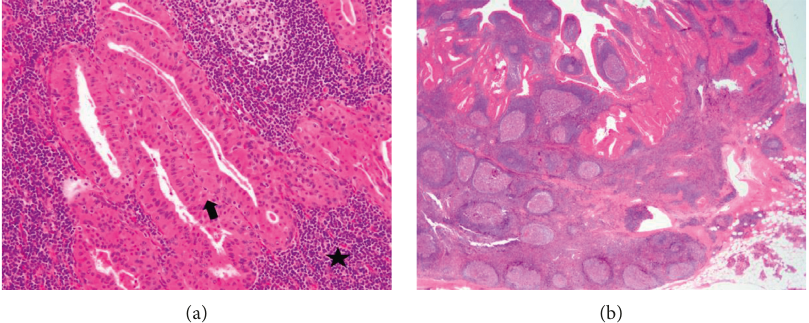
Figure 2: Hematoxylin and eosin stains of pathologic specimen (higher magnification on left). Note dense lymphoid stroma (star) with double layer of epithelial cells (arrow) and cystic